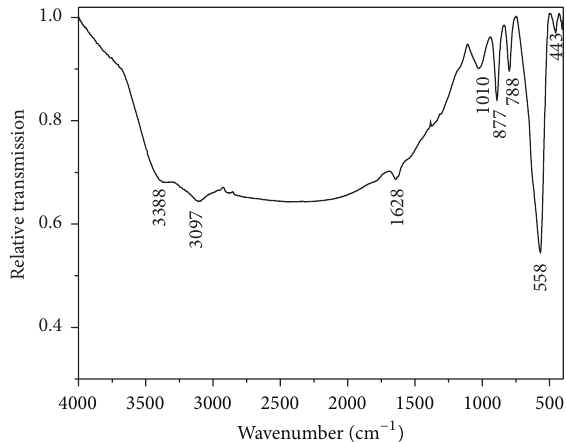
Figure 2: The FTIR spectra of 𝛾 -Fe 2 O 3 powder prepared at 60 ∘ C and pH 6.0 for 6h.